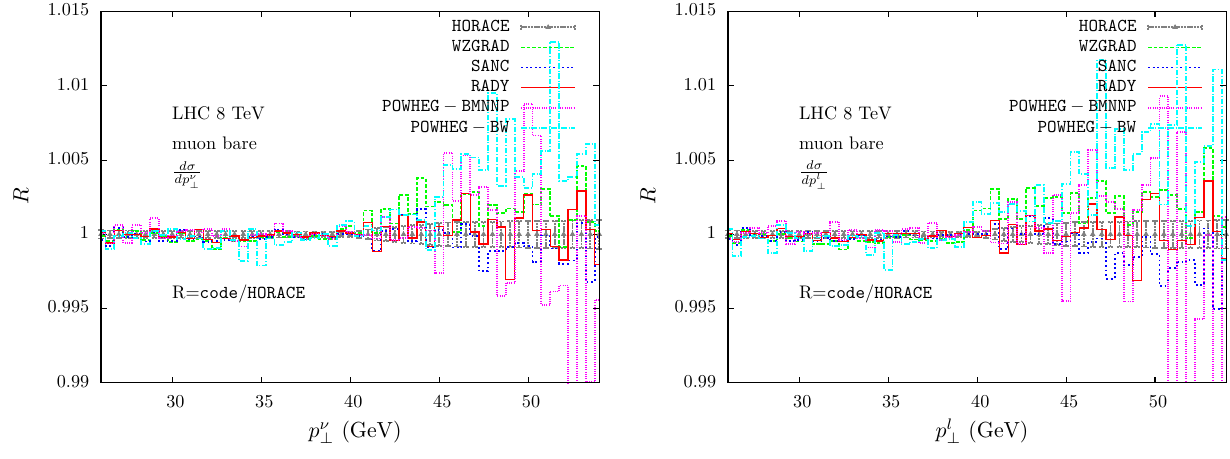
Fig. 1 Tuned comparison of the lepton-pair transverse mass and transverse momentum distributions in pp → W + → μ + ν μ + X at the 8 TeV LHC with ATLAS/CMS cuts in the bare setup, including NLO EW corrections